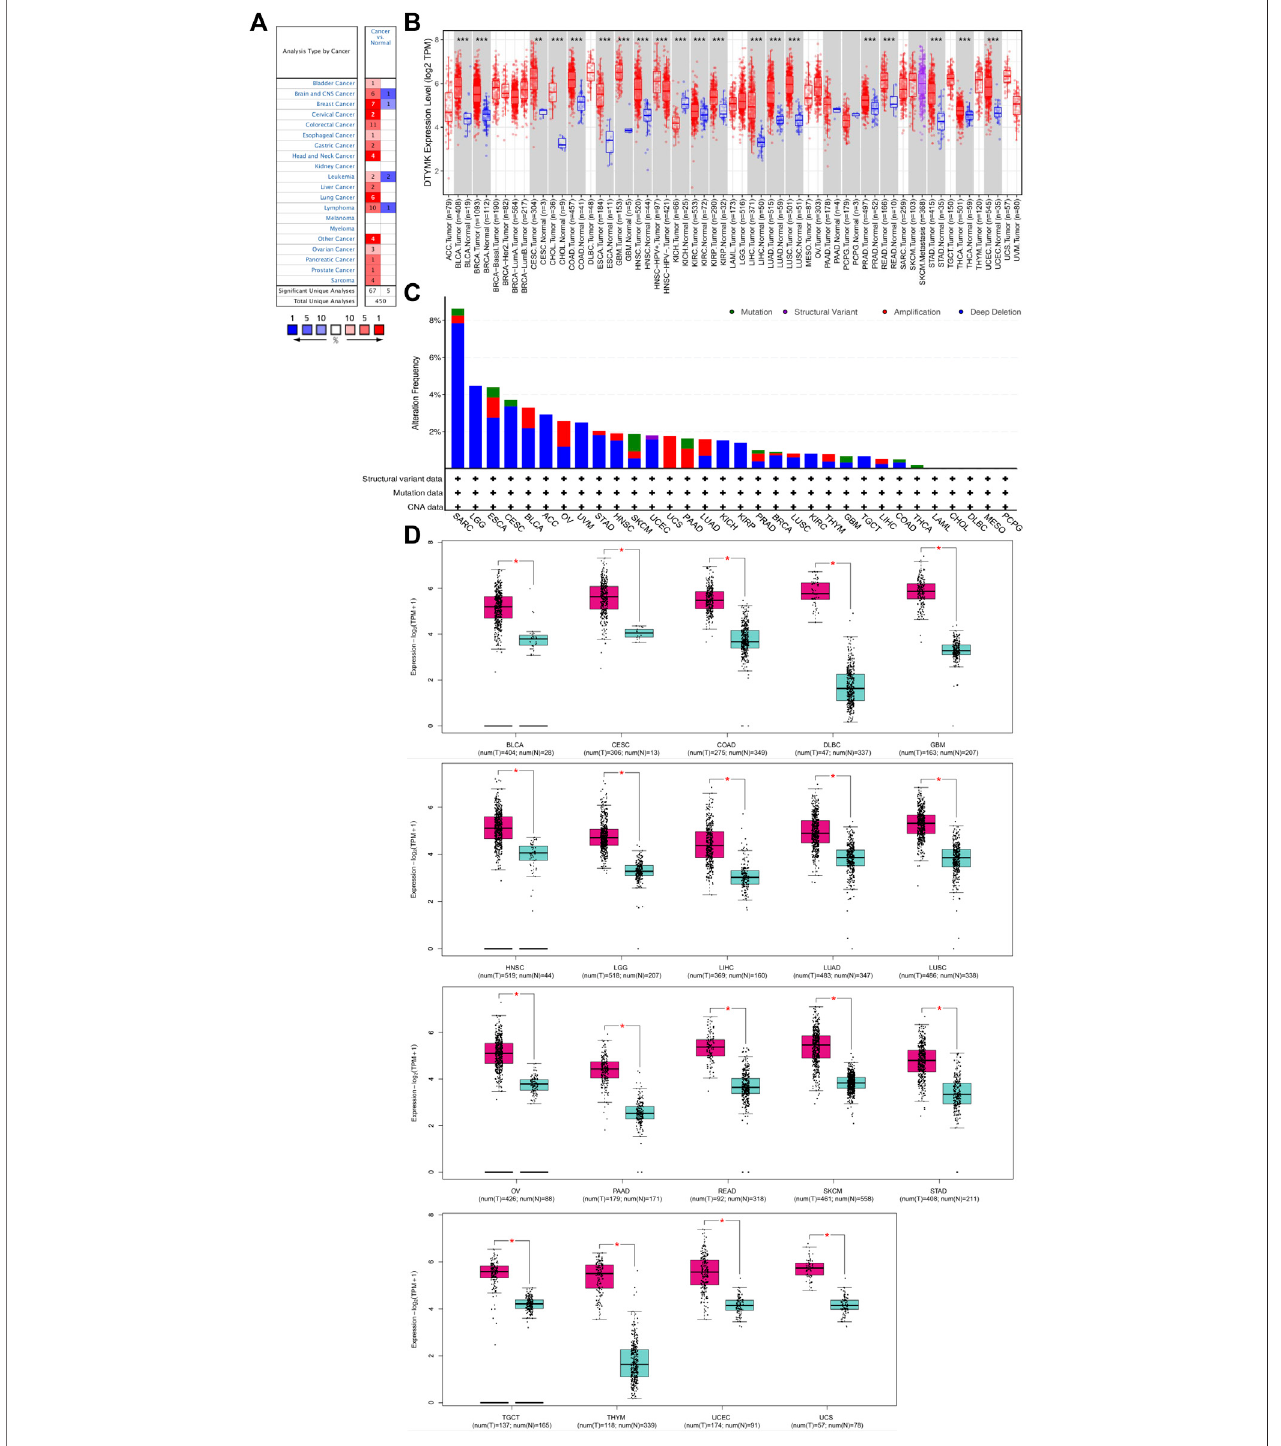
FIGURE1| DTYMKexpressionisupregulatedinmosttypesofcancerscomparedwithcontrols. (A) ExplorationofDTYMKmRNAexpressioninhumancancersas determined using the Oncomine database. Numbers in red boxes indicates studies that showed increased DTYMK expression in tumors; numbers in blue indicates studies that showed decreased DTYMK expression. (B) Comparison of DTYMK mRNA expression in human cancers using the TIMER database. (C) Pro fi le of DTYMK expression variation and mutation in cancers using the cBioPortal database. (D) Comparison of DTYMK mRNA expression between tumor tissues and normal tissues using GEPIA database. * p < 0.05, ** p < 0.01, *** p < 0.001.